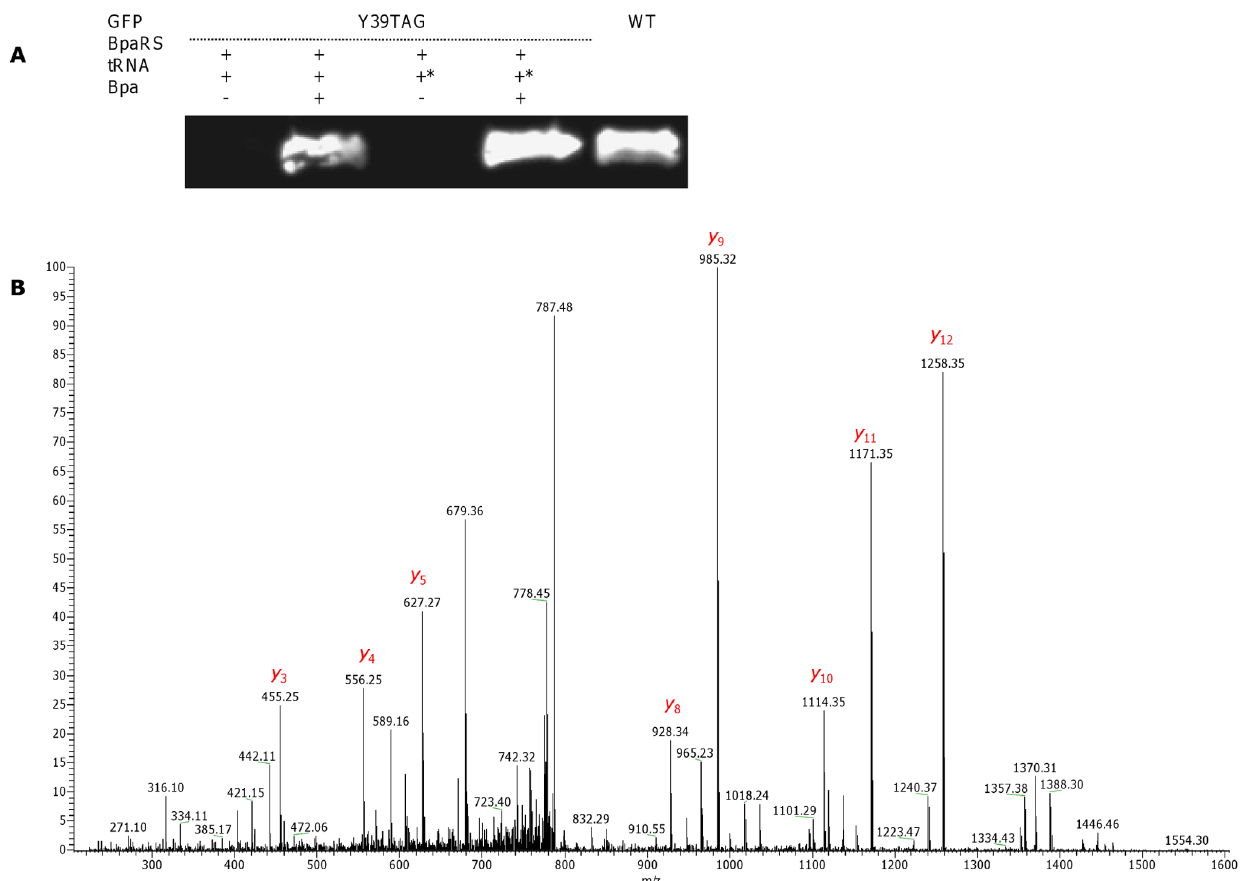
Figure 6. Site-specific pAcPhe incorporation into GFP in a cell-free expression system. (A) Western blot visualization of WT GFP and pAcPhe-incorporating GFP Y39TAG. The synthesis of GFP was performed using an in vitro translation kit. Co-translational incorporation of pAcPhe was achieved upon addition of the corresponding plasmid (500 m g/mL), M. jannaschii pAcPheRS (100 m g/mL), different types of suppressor tRNA (480 m g/mL), and pAcPhe (1 mM) to the reaction medium. tRNA denotes synthetic Mj tRNA CUA , Opt – tRNA CUAOpt . (B) Annotated average MS/MS spectrum of peptides with m/z 765.84 corresponding to pAcPhe-incorporated FSVSGEGEGDATY*GK peptide of GFP Y39TAG. The Y* ion corresponding to pAcPhe (calculated m/z , 393.24; observed m/z , 393.23) can be easily detected. The distinguishing mass shift of 26 Da can be observed for most abundant ‘‘y’’ ions. For clarity, only the most abundant ‘‘y’’ ions are assigned.